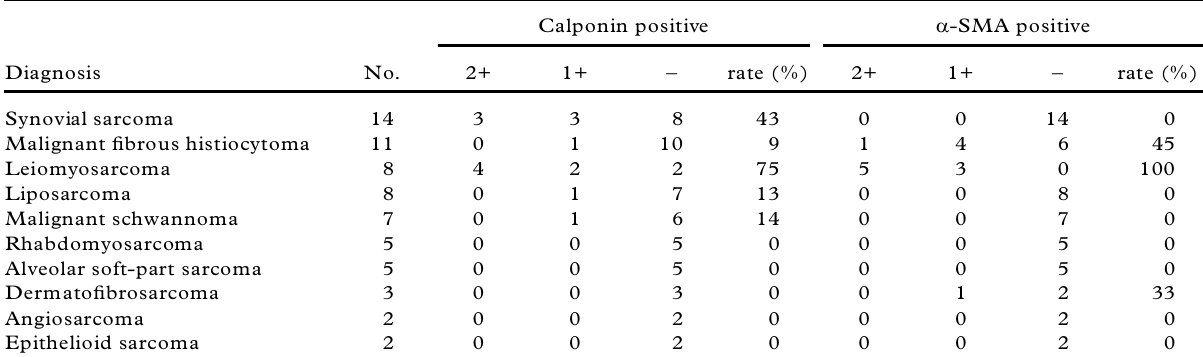
Table 1. Immunohistochemical analyses of smooth muscle calponin and a -smooth muscle actin in soft tissue